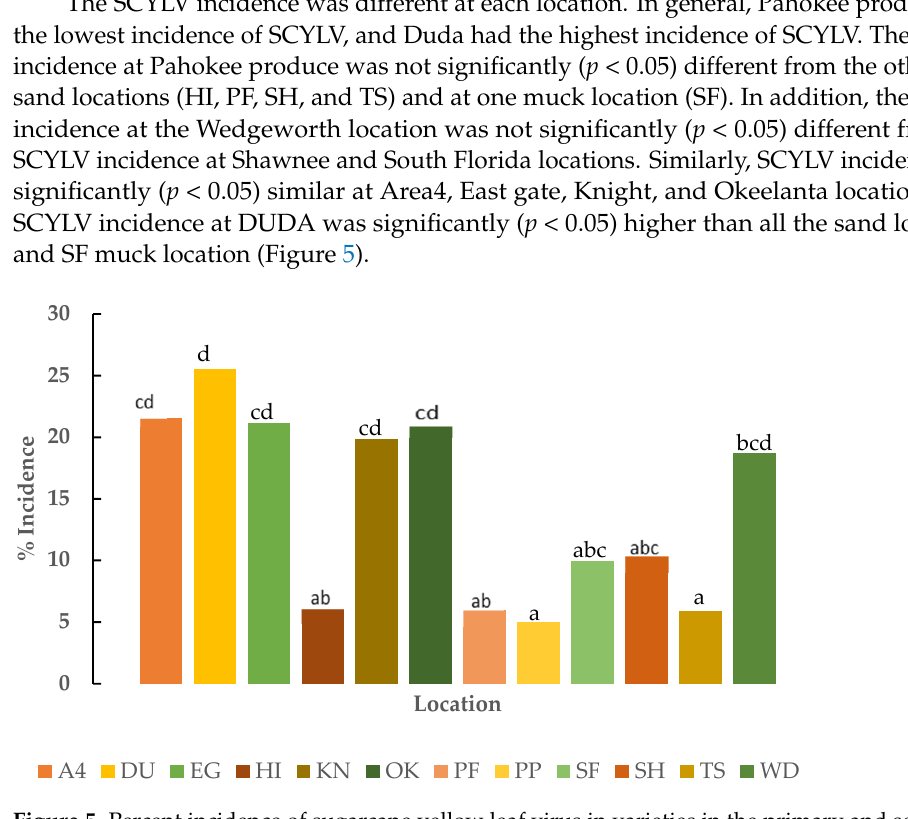
Figure 5. Percent incidence of sugarcane yellow leaf virus in varieties in the primary and secondary increase trials at different locations. Locations are Area 4 (A4), Duda (DU), Eastgate (EG), Hilliard (HI), Knight (KN), Okeelanta (OK), Pahokee Produce (PP), Perry Farm (PF), Shawnee (SH), South Florida (SF), Townsite (TS), and Wedgeworth (WD). Percent incidence values with different lower case letters are significantly different ( p < 0.05).